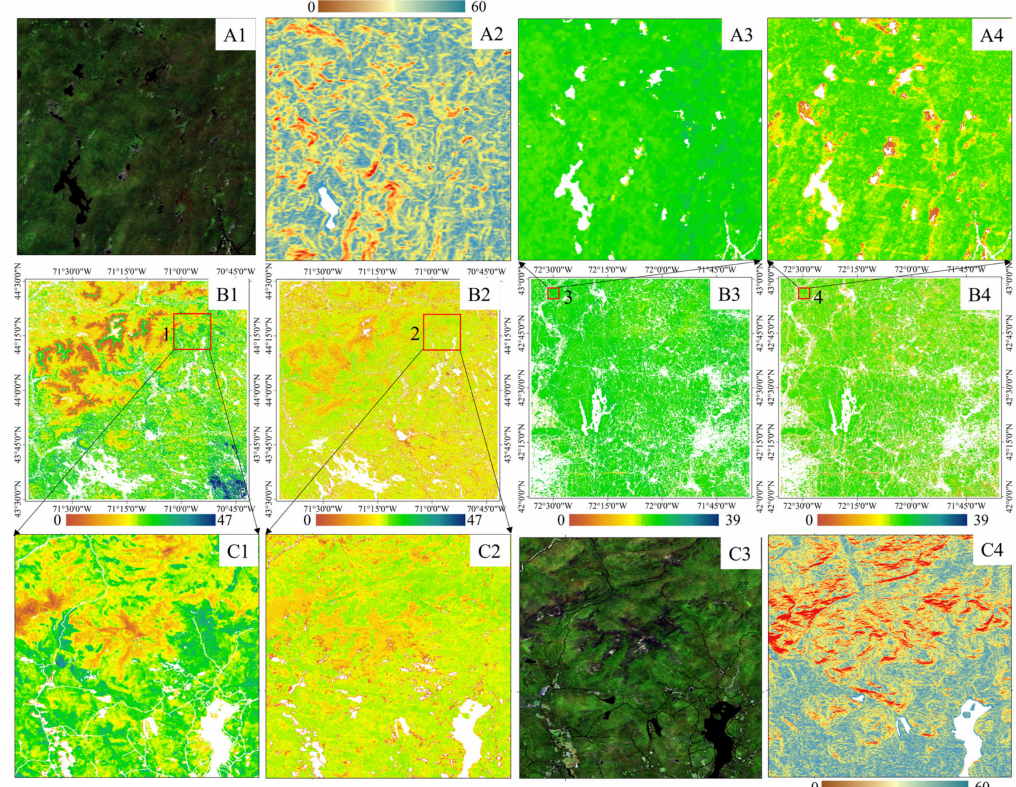
Figure 4. Comparison of canopy height spatial distributions in Area 1 ( B1 , B2 ) and Area 2 ( B3 , B4 ). ( A1 , C3 ) are true color images, while ( A2 , C4 ) are the topographic slopes of the enlarged rectangle in Area 1 ( C1 , C2 ) and Area 2 ( A3 , A4 ), respectively. ( B1 , B2 ), and ( B3 , B4 ) are C-CH and GDAL RH95 in Area 1 and Area 2, respectively. The true color images are composited with the blue, green, and red bands of Sentinel-2. Masked areas are displayed in